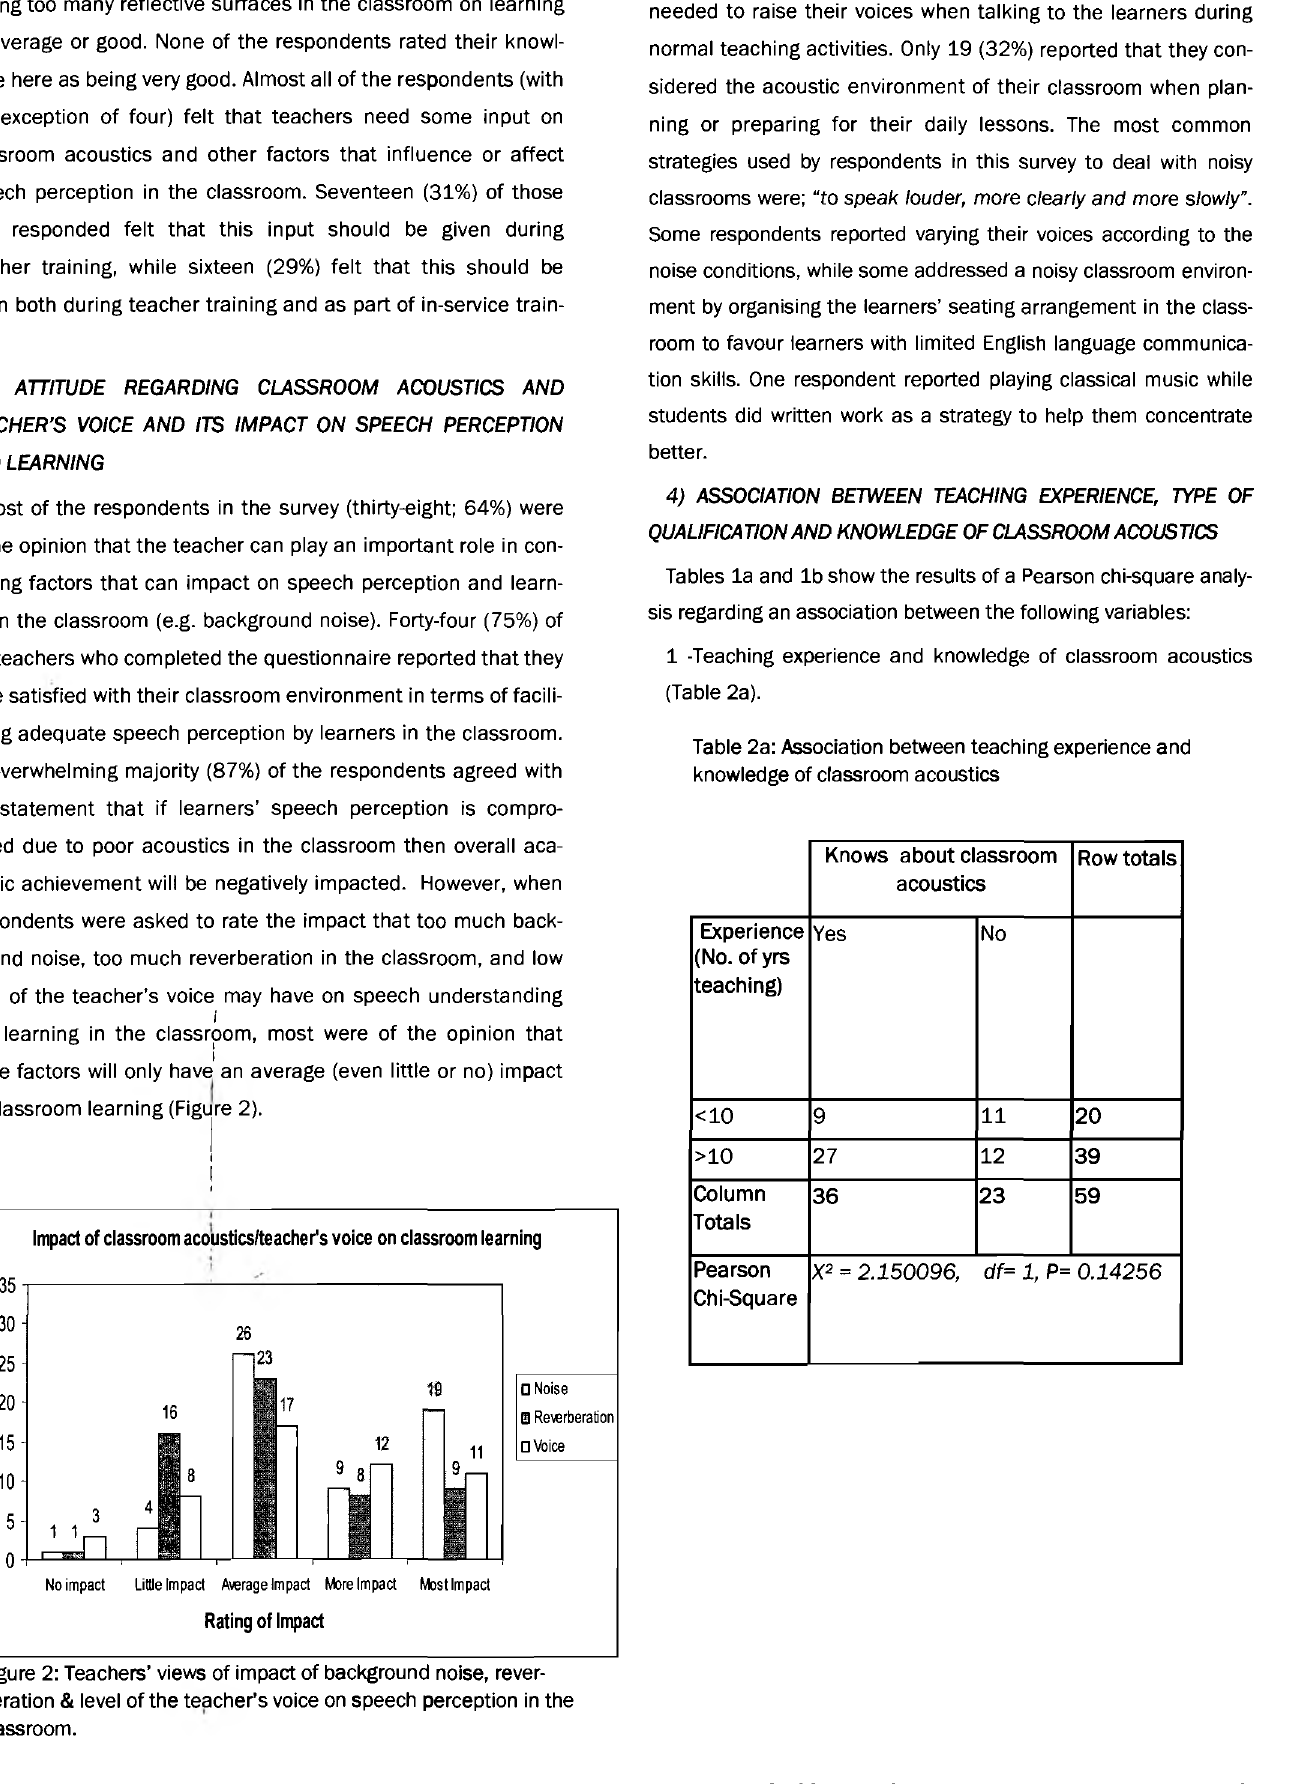
Table 2a: Association between teaching experience